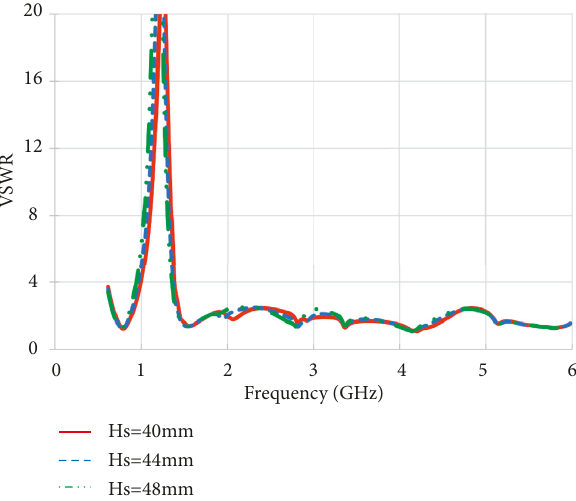
Figure 6: Effect of the slot length (Hs) on the antenna